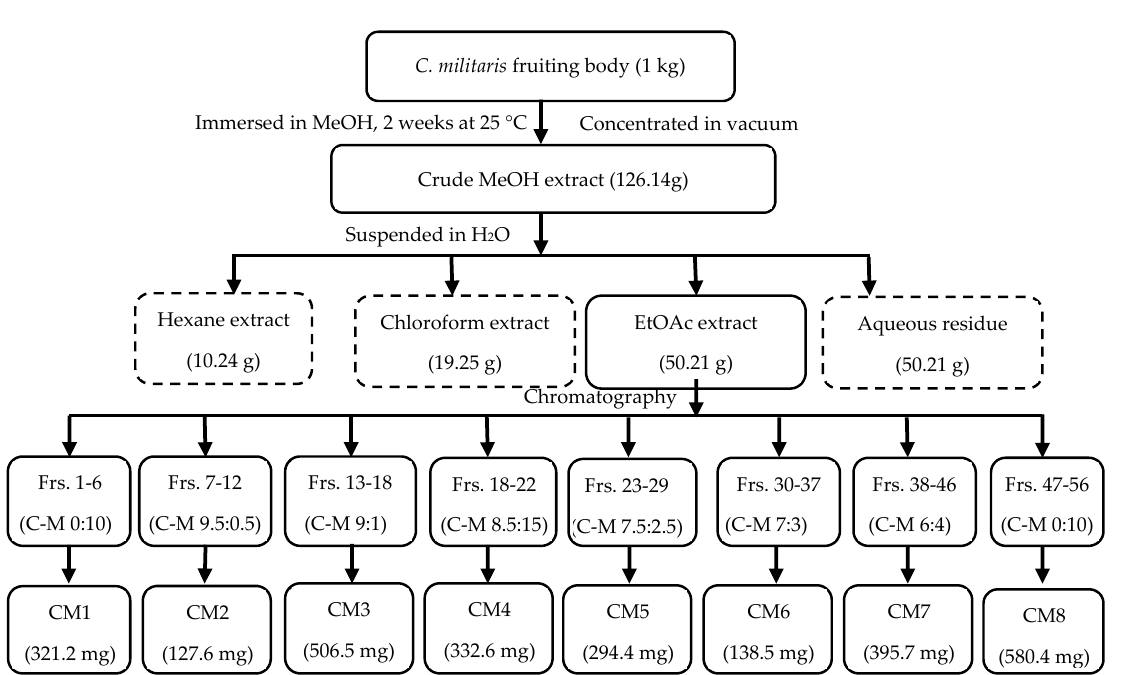
Table 2. Effects of different fractions of C. militaris on germination and growth of radish.